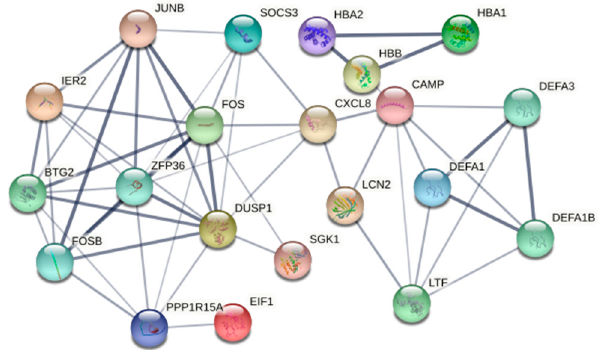
Figure 5. The 21 hub genes in the Black module among the PPI network.